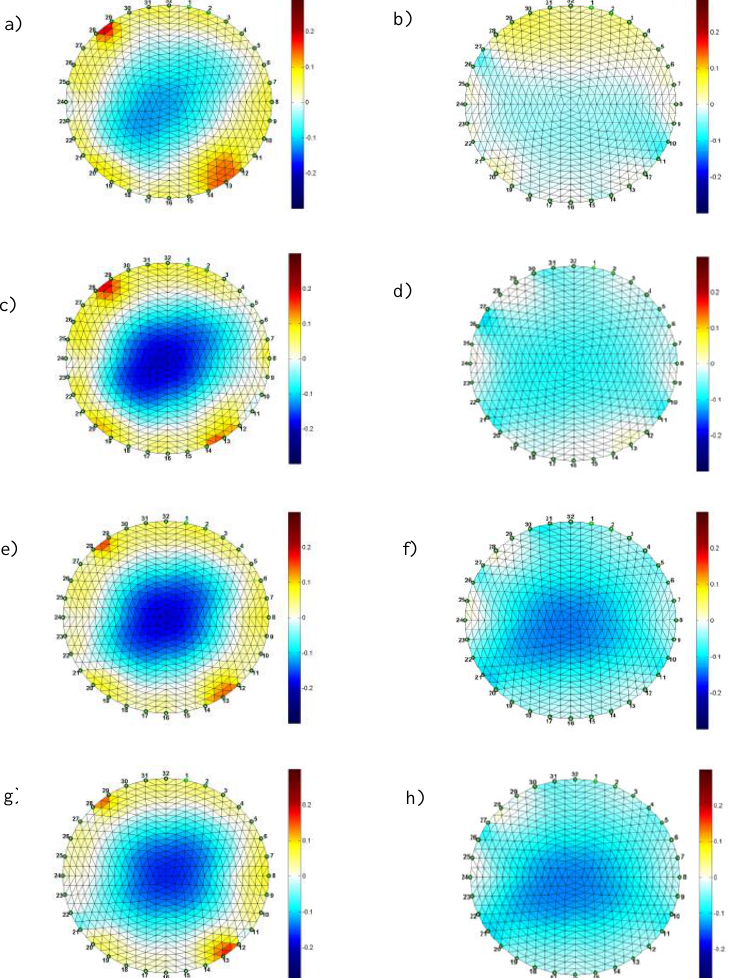
Figure 8. EIT images obtained with a concentration of ≅2.35% (w/w) of Pine (left column: ( a , c , e , g )) and Eucalyptus (right column: ( b , d , f , h )) fibres with increasing flow velocity (0.5 m/s, 1m/s, 2m/s and 3m/s, top to bottom).